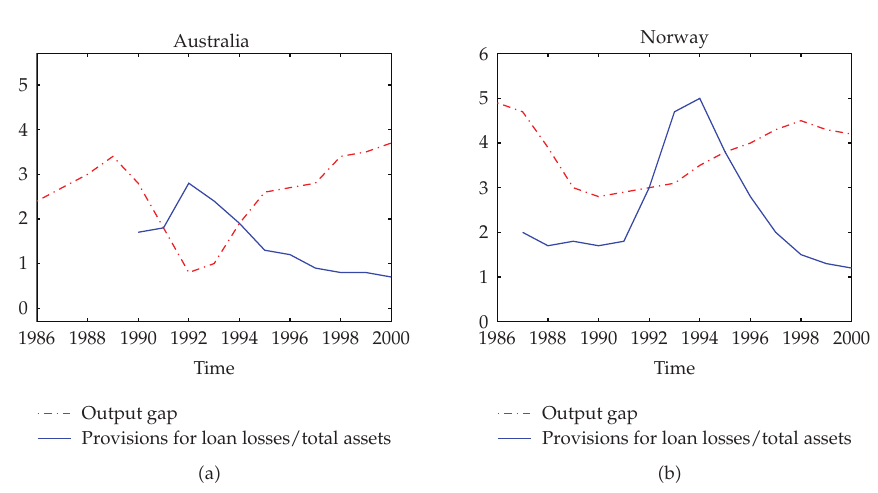
Figure 1: Output gap versus provisions for loan losses-to-total assets ratio for Australia and Norway (cid:2) 1986– 2000 (cid:3) .